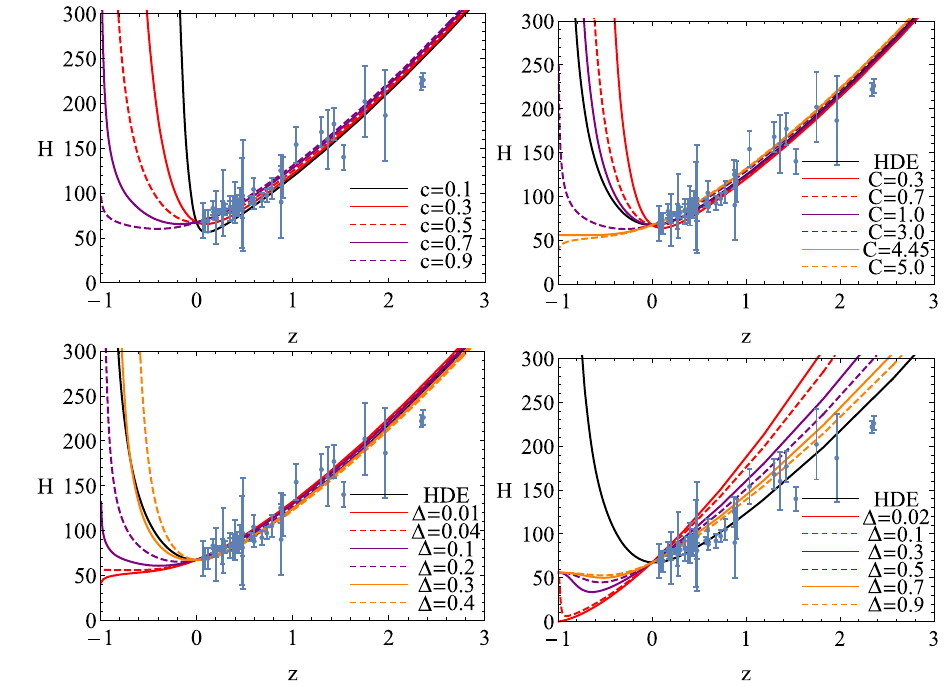
Fig. 26 Evolution curves of H . The left panel was plotted for HDE, while the right one was shown for BHDEF with (cid:5) = 0 . 1